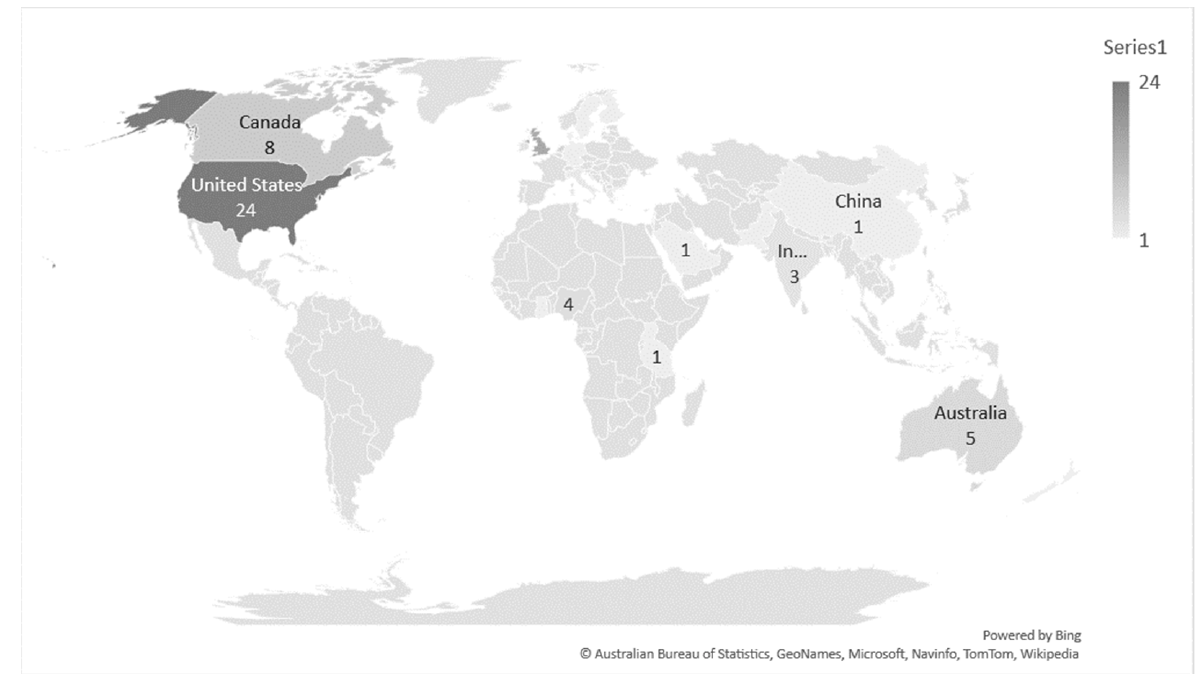
Figure 2. Geographical distribution of the included papers.